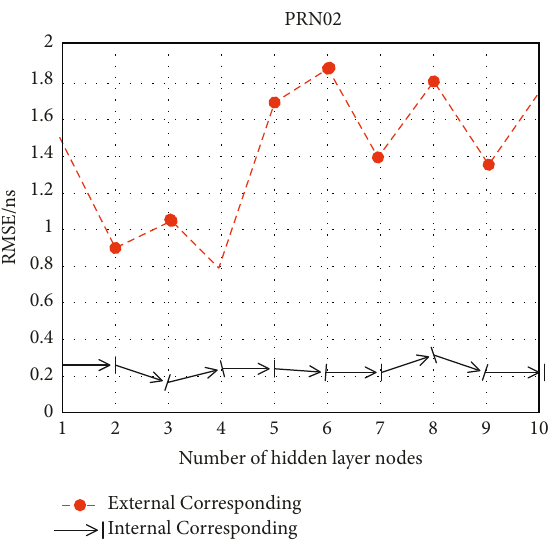
Figure 7: The relationship between the number of hidden layer nodes and the model accuracy.